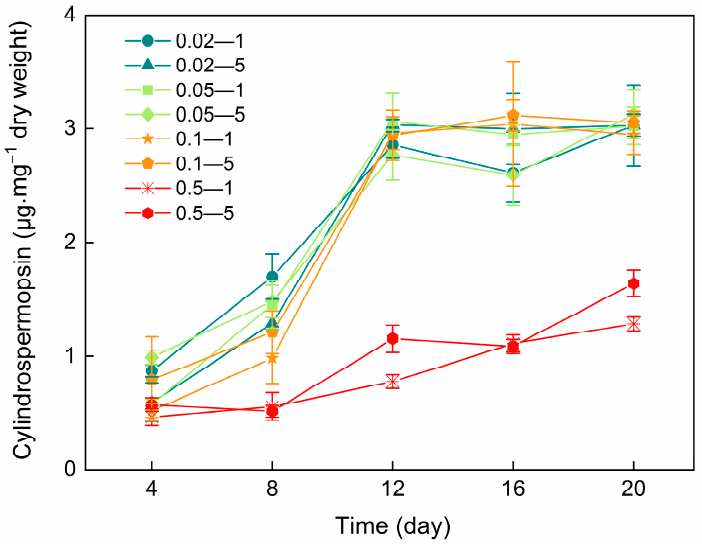
Figure 7. The CYN dynamics of C. ovalisporum in the different treatments.